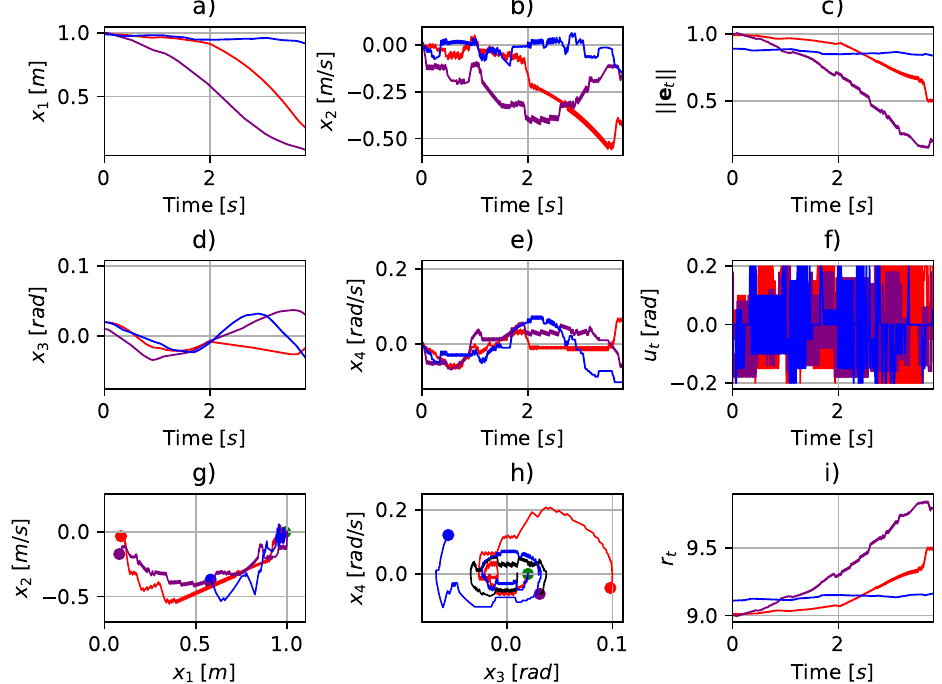
Figure 6. Comparative results for landing a rocket: classical box method CBM1 ( blue ), variable box method VBM1 ( red ), and VBM2 ( purple ), where the purple and black dots represent the initial and desired conditions, respectively. Subfigures depict the following: ( a , b , d , e ) show the rocket descending phase, for height velocity x 2 , angle x 3 , and angle velocity x 4 remain bounded while tracking errors remain near zero; ( a ) shows the better performance of our proposal, ( c ) shows how the error norm decreases while the reward increases ( i ), the control signal performance u t is show in ( f ), and phase portraits are show in ( g , h